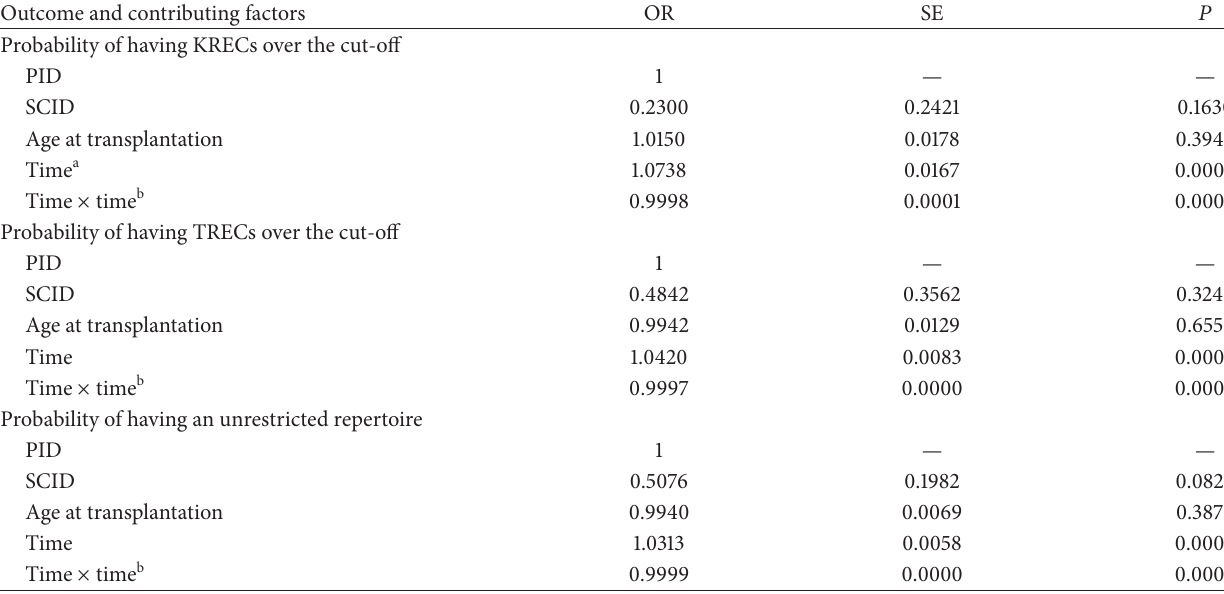
Table 2: Multivariable logistic models investigating differences in immune reconstitution between HSCT-SCID and -PID patients. Outcome and contributing factors